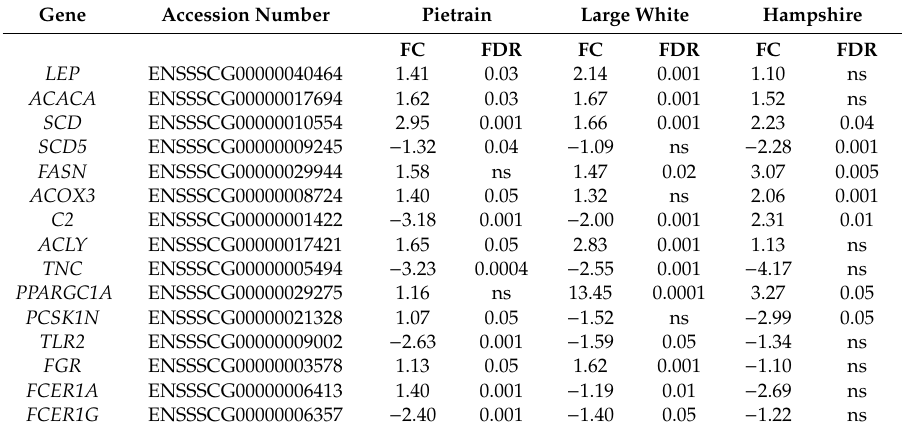
Figure 2. The significant enrichment GO terms and pathways identified based on backfat thickness differences and related to lipid metabolism (WebGestalt software). Table 3. The fold-change values of DEGs related to lipid metabolism and detected as significant for at least two breeds.